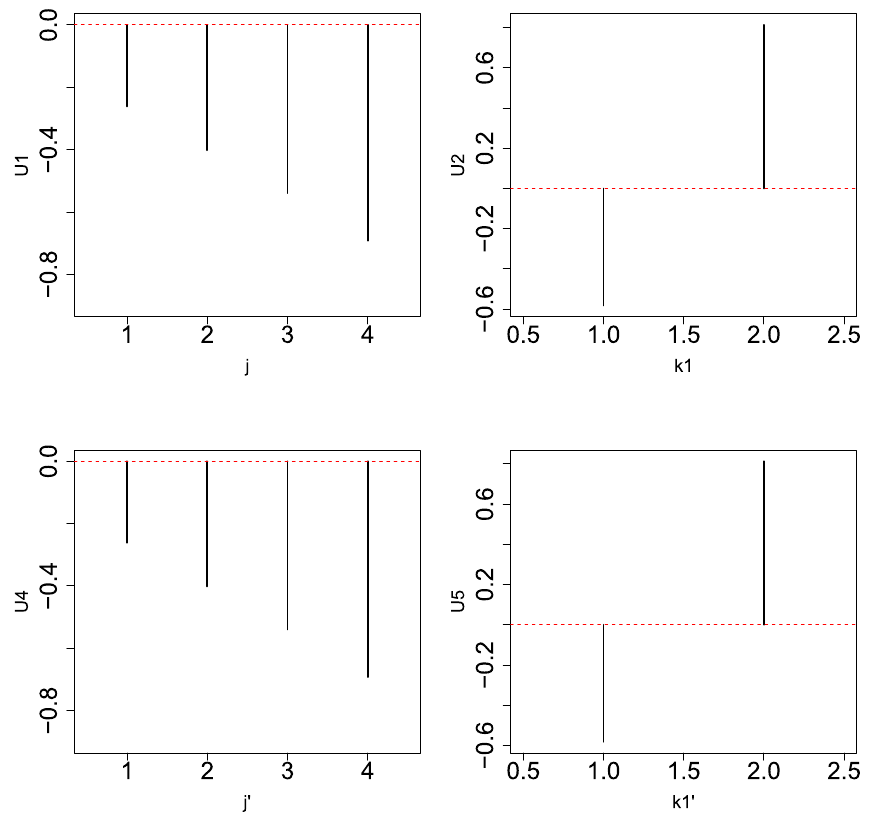
Figure 9. Singular value vectors obtained when KTD-based unsupervised FE was applied to the 2nd synthetic data set. Upper left: u 1 j , upper right: u 2 k 1 , lower left: u 1 j ′ , lower right: u 2 k ′ indicates baseline (zero).